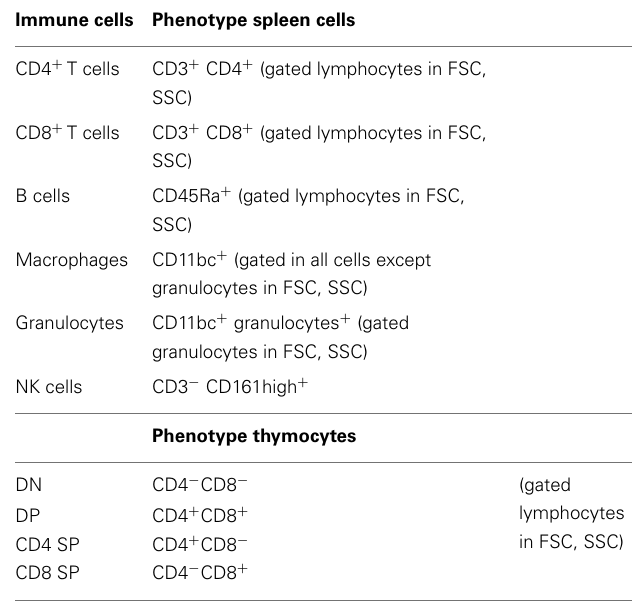
Table 1 |Antibodies used for the identification of different immune cells .